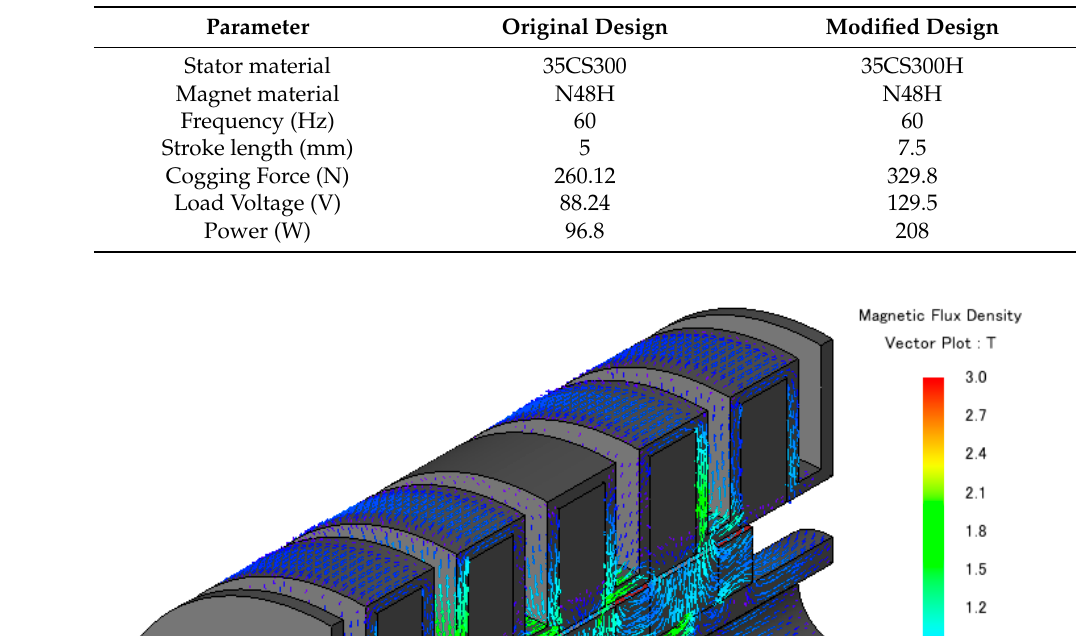
Table 5. Increase in power via modification.